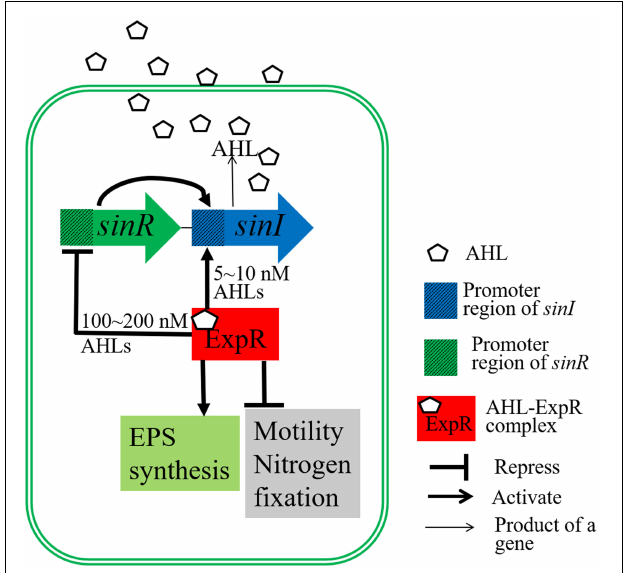
FIGURE 1 | Regulatory diagram of the S. meliloti quorum sensing system. The transcription of sinI, which encodes AHL synthase, is induced by SinR. sinI transcription can also be induced by the AHL-ExpR complex at low AHL concentrations (5 ∼ 10 nM). The AHL-ExpR complex represses sinR expression at high AHL concentrations (100 ∼ 200 nM). Furthermore, the AHL-ExpR complex induces the expression of genes related to EPS biosynthesis, and represses the expression of genes important for motility, nodulation, and nitrogen